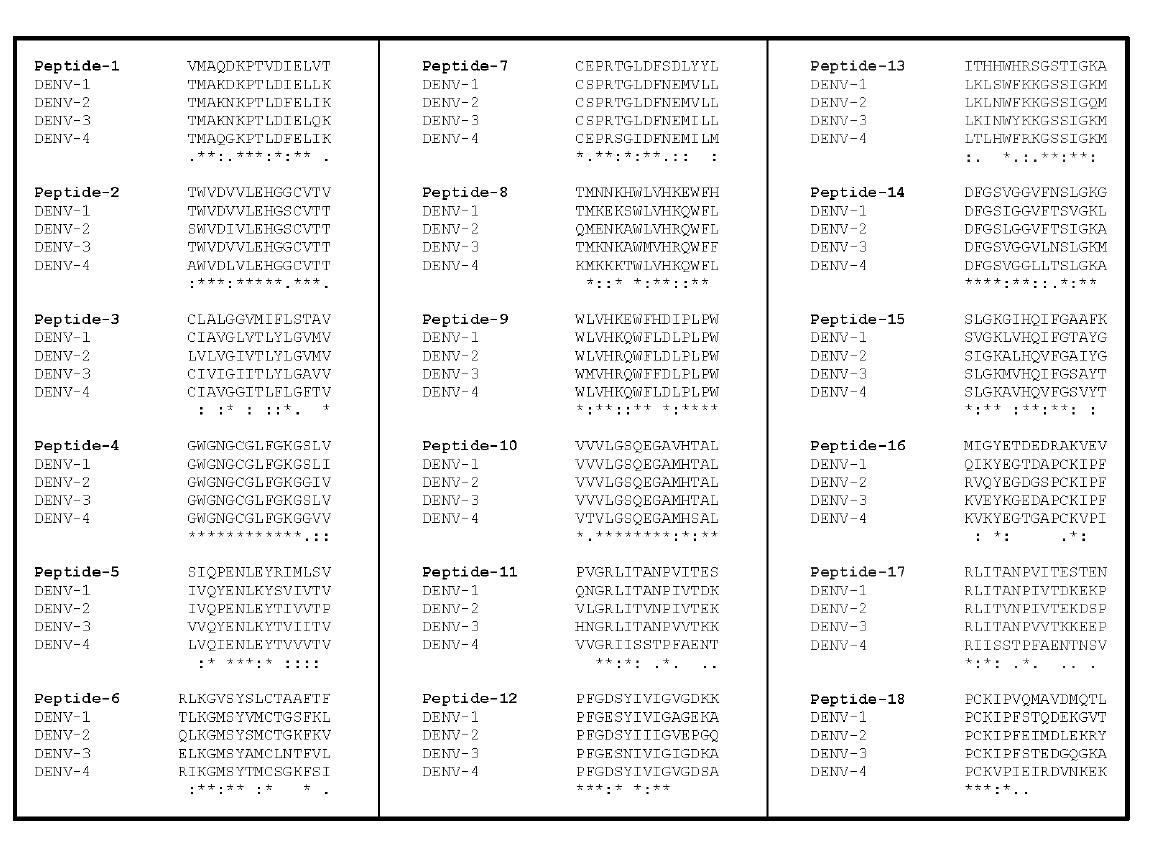
Figure 1. Alignment of ZIKV and DENV Sequences. The ZIKV amino acid sequences of selected pep- tides were aligned to the corresponding DENV-1, DENV-2, DENV-3, and DENV-4 sequences using EM- BL-EBI bioinformatics framework. * indicates positions with a single, fully conserved residue; : indicates conservation between groups of strongly similar properties—roughly equivalent to scoring > 0.5 in the Gonnet PAM 250 matrix; . indicates conservation between groups of weakly similar properties—roughly equivalent to scoring ≤ 0.5 and > 0 in the Gonnet PAM 250